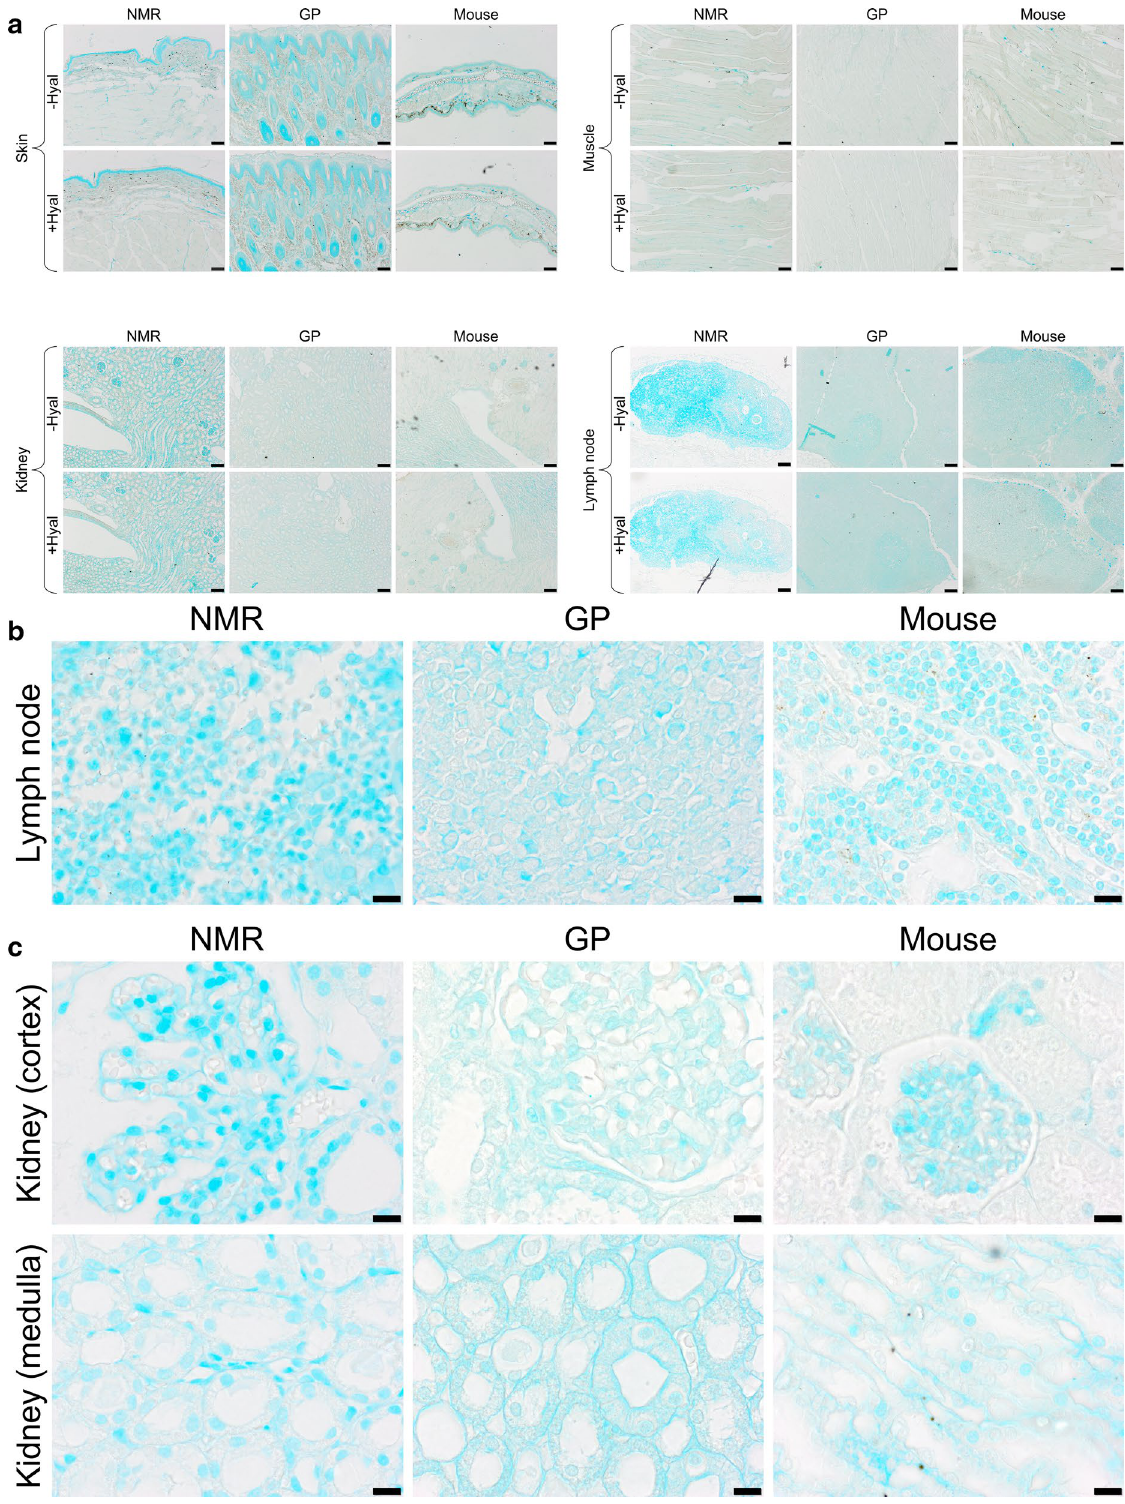
Figure 1. Alcian blue staining of NMR, GP, and mouse tissues. ( a ) NMR, GP, and mouse tissues (skin, muscle, kidney, lymph node) stained with Alcian Blue, with (+) or without (−) 3-h pre-incubation with 100 U/ml hyaluronidase from Streptomyces hyalurolyticus . Scale bars, 100 µm. ( b ) NMR, GP and mouse lymph node and ( c ) NMR, GP, and mouse kidney (cortex and medulla) at higher magnification. Scale bars, 10 µm. NMR, naked mole-rat; GP, guinea